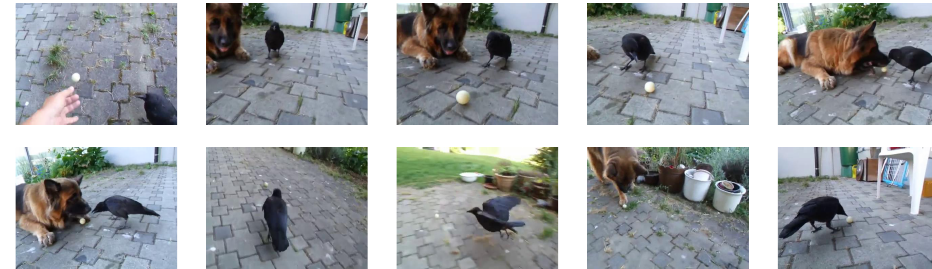
Figure 6. Examples of frame labels from the “playing ball”